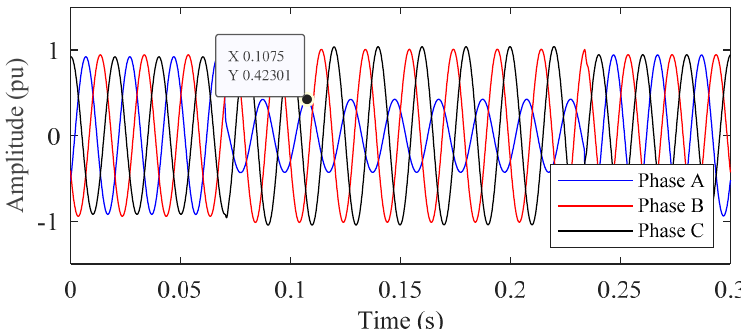
Figure 15. Related STA plots of PQ event when phase A to ground fault occurs at F.1: ( a ) TvA ; ( b )